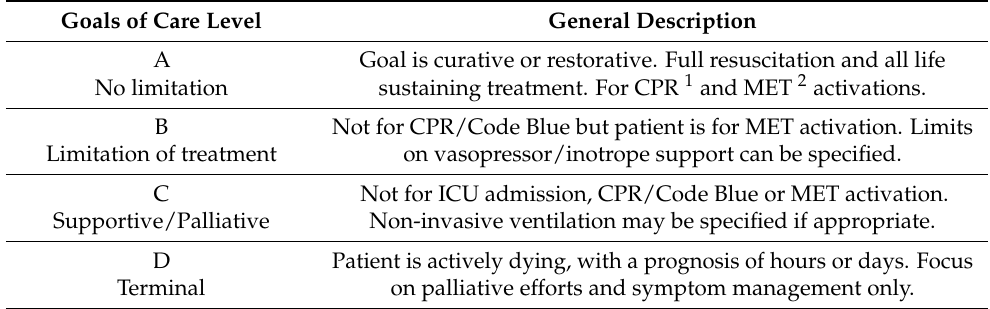
Table 1. Summary of goals of care categories (levels). Goals of Care